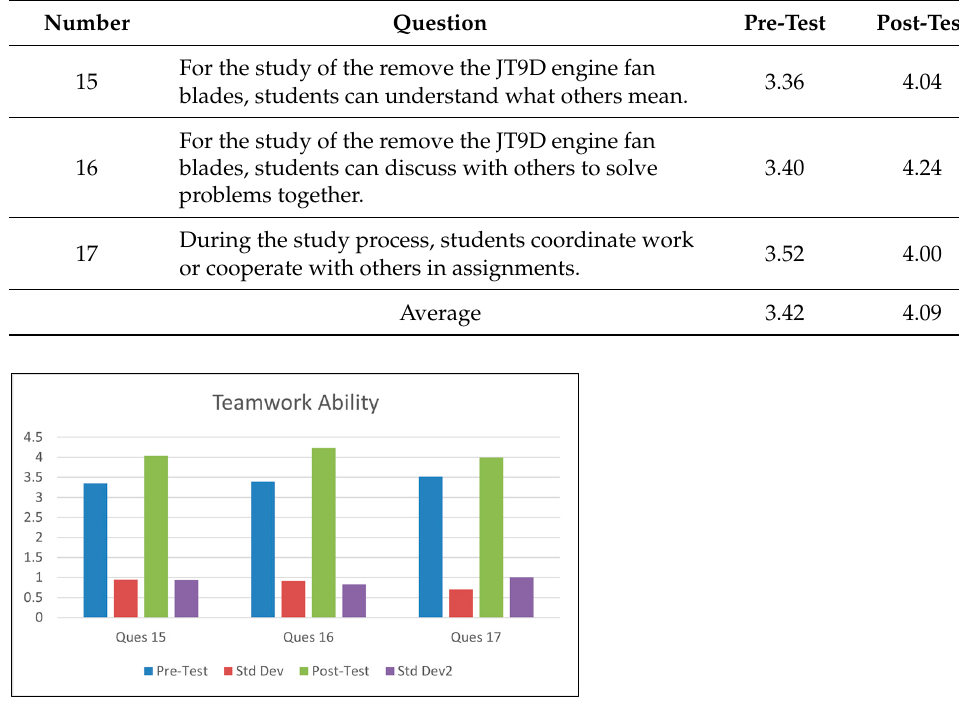
Table 7. Results for teamwork.